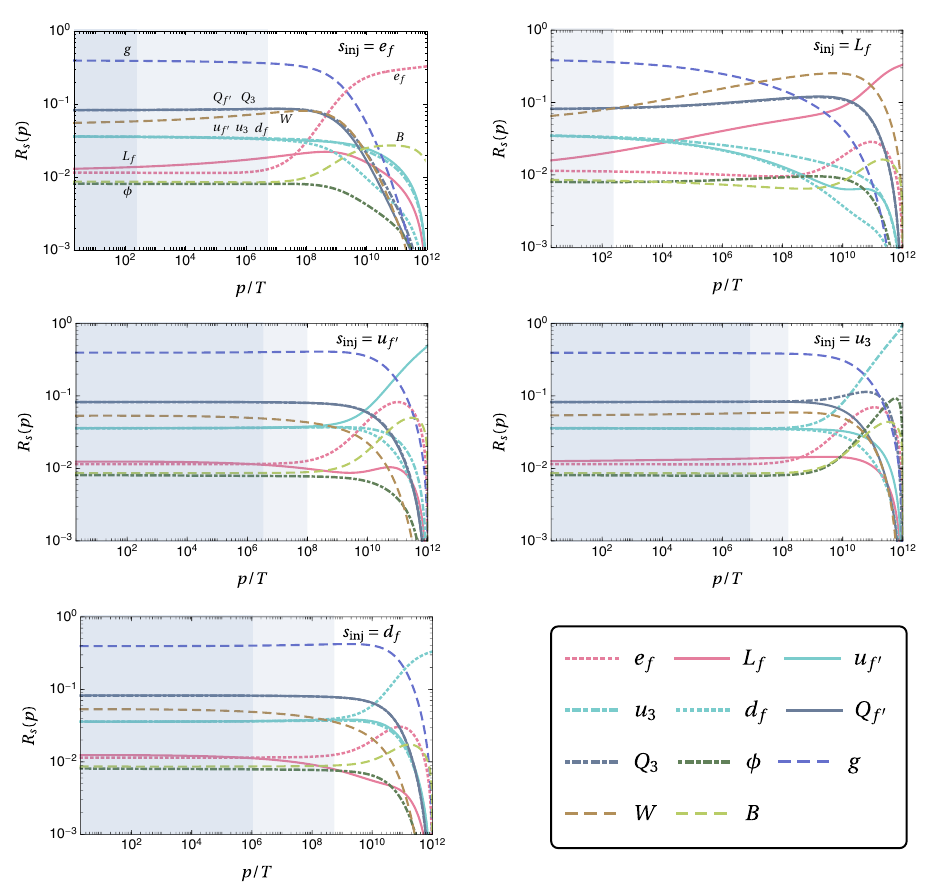
Figure 5 . Fraction of species s at an energy p , R s ( p ) . The primary particle is injected solely for e f (upper left), L f (upper right), u f 0 (middle left), u 3 (middle right), and d f (lower left). The dark and light shaded regions represent p < p ( s ) asym and p < p ( s )